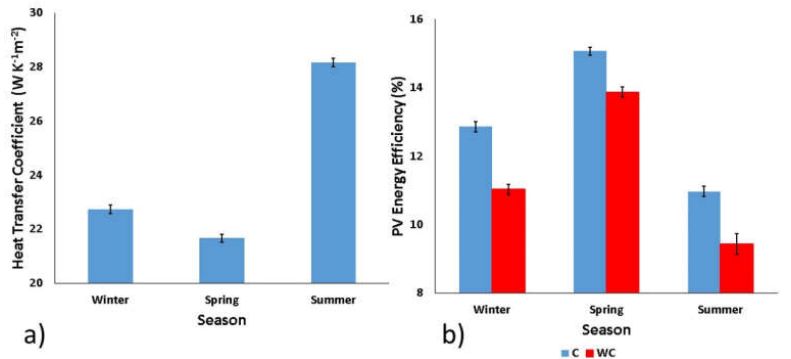
Figure 9. ( a ) Global heat transfer coefficient in different seasons of the year and ( b ) energy efficiency for the PV module in different seasons of the year. C = cooling system and WC = without cooling system.